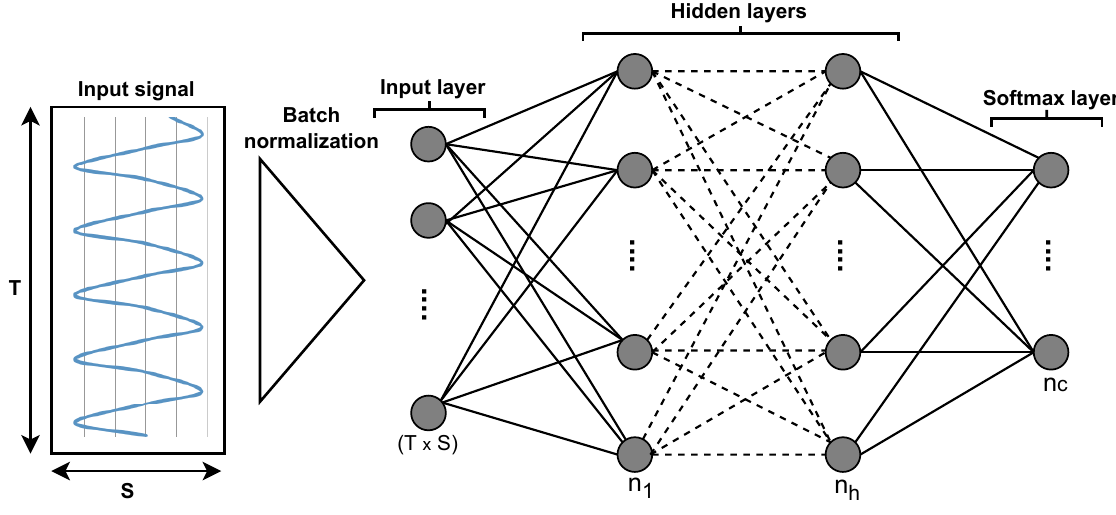
Figure 3. Illustration of a MLP where different sensor channels are converted into a (T × S) dimensional vector, which is passed to the different hidden layers (h) and output classes (c) as defined by the softmax